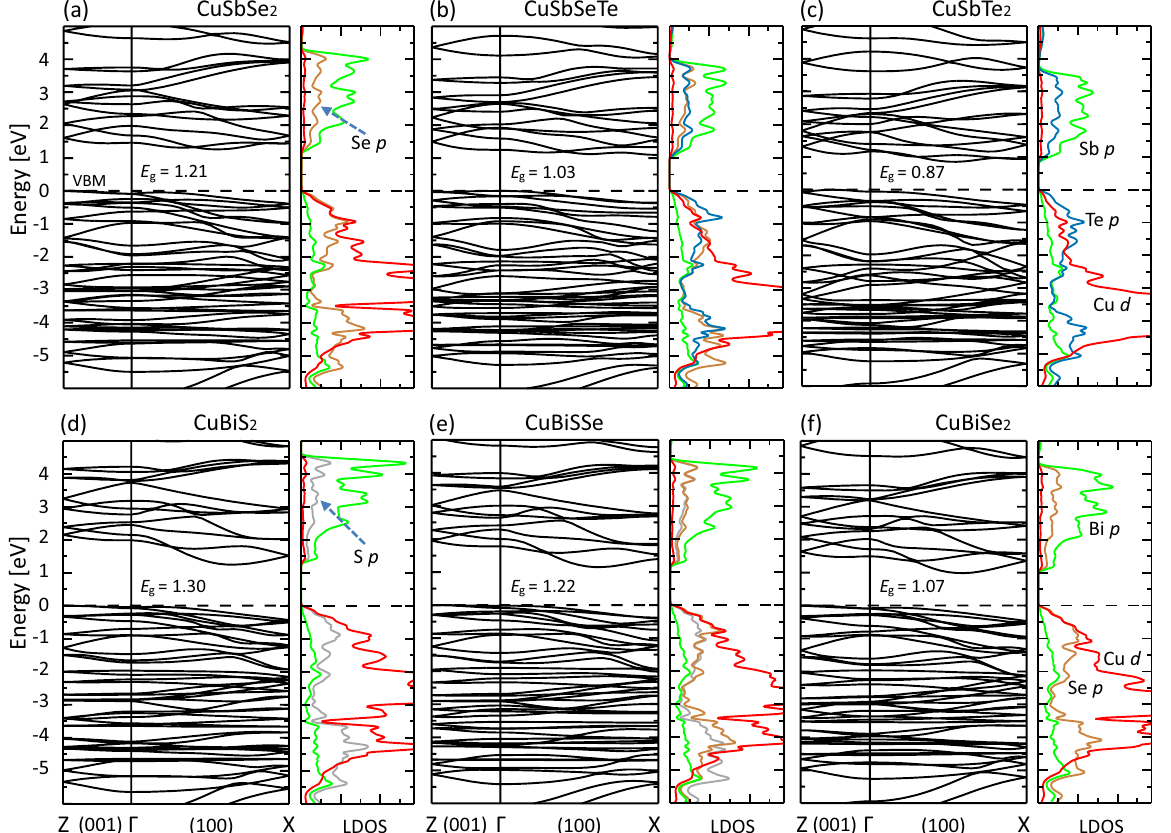
Fig. 1. Electronic band structure and LDOS of (a) CuSbSe 2 , (b) CuSbSeTe, i.e., 50% alloying, (c) CuSbTe 2 , (d) CuBiS 2 , (e) CuBiSSe, 50% alloying, and (f) CuBiSe 2 . The energy refers to the VBM (dashed lines). The atom- and angular momentum resolved density-of-states has been scaled with 1/(2 l + 1) for better visualization, and it is presented with a 0.20 eV Lorentzian broadening. One can notice the strong Sb/Bi p -like states in the lower energy region of the conduction